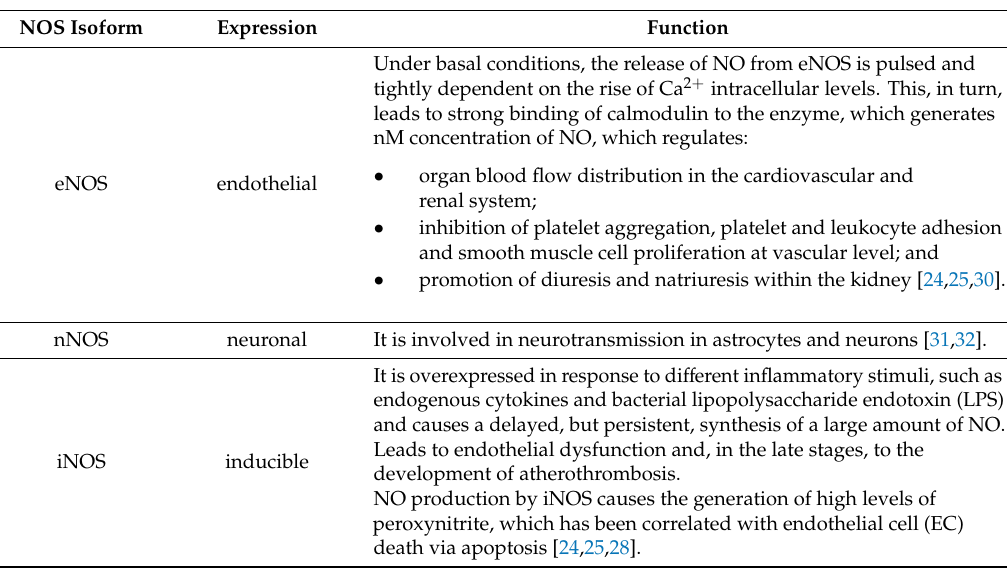
Table 1. Expression and functions of di ff erent nitric oxide synthase (NOS)